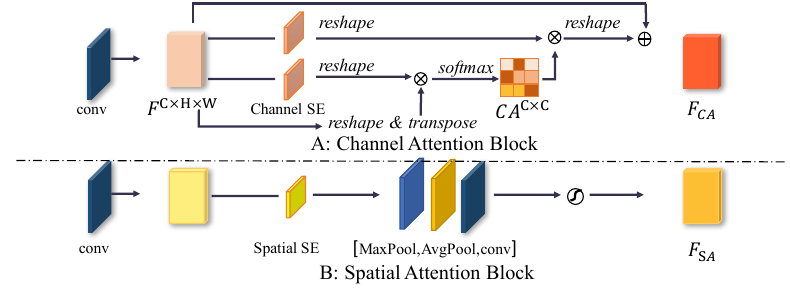
Figure 3. Architecture of the dual attention